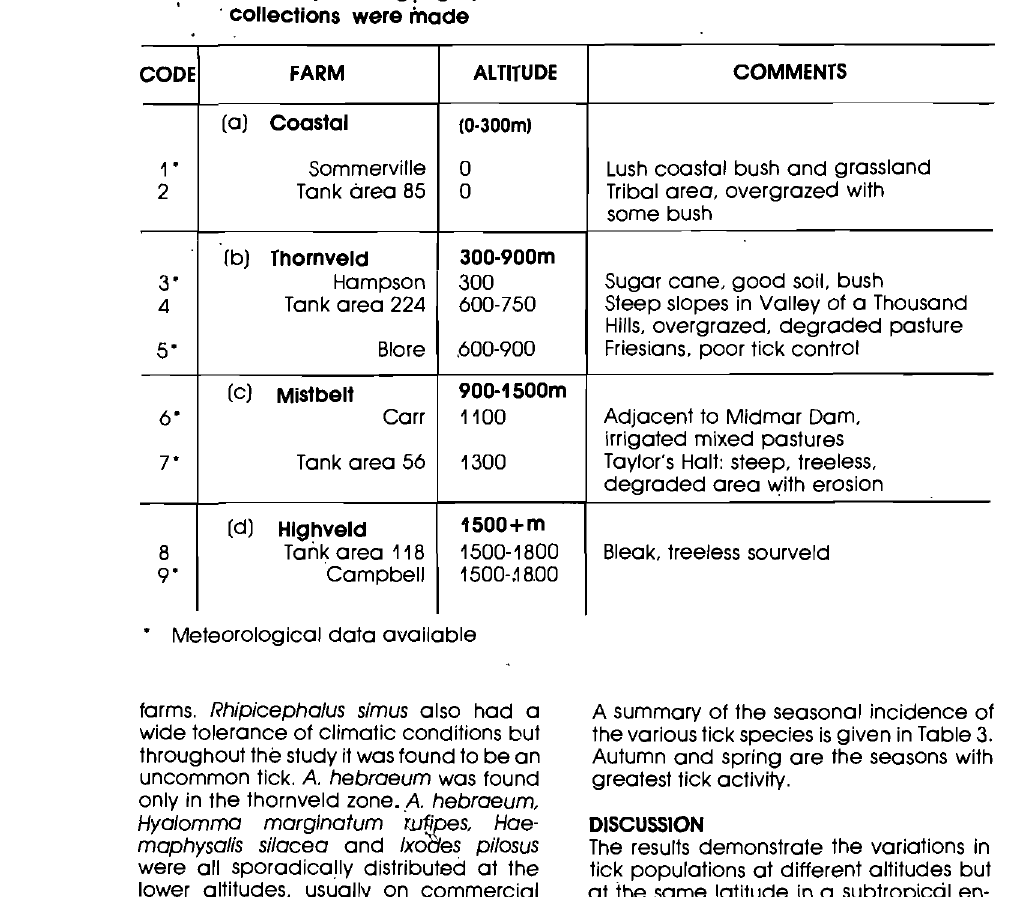
Table 1: Summary of the g~ographlcallocations of the farms in Natal on which , . collections were made